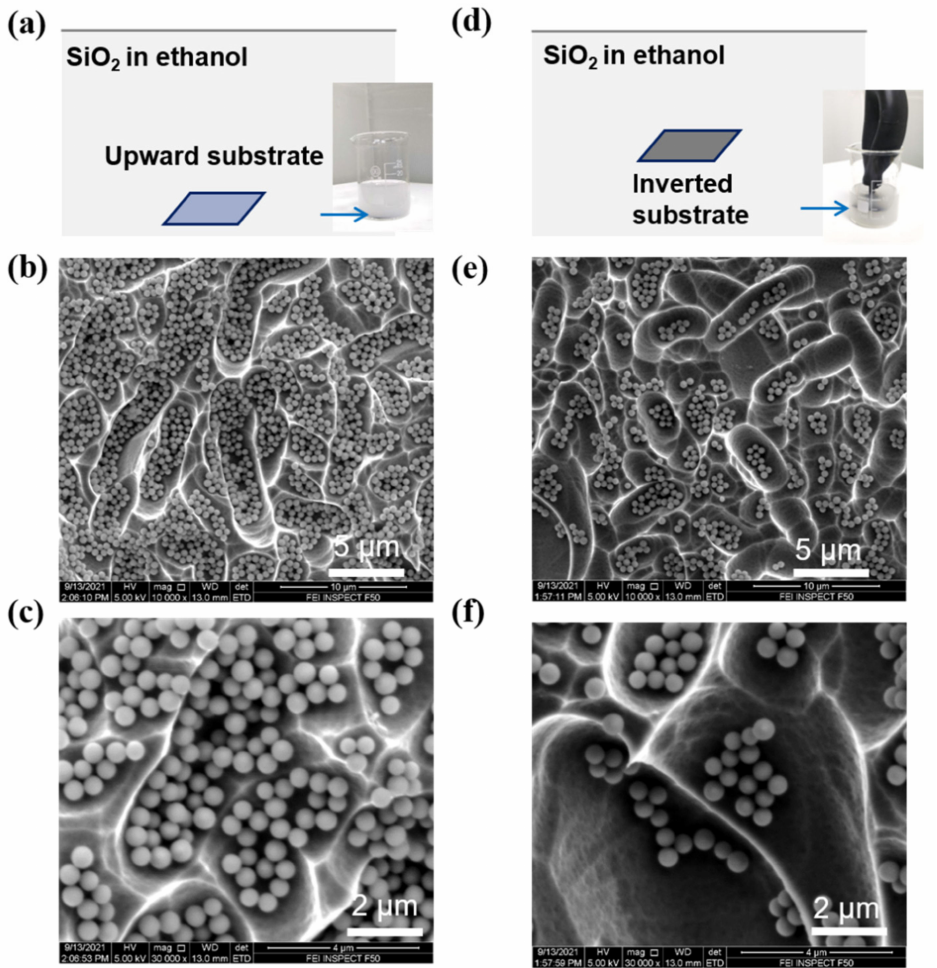
Figure 3. Self-assembly nanocoating under different substrate orientations in the SiO 2 assembly colloid: ( a – c ) Self-assembly with an upward substrate; ( d – f ) Self-assembly with an inverted substrate. The assembly time was fixed to 10 min for all the assembly processes, and the inset figures in ( a ) and ( d ) are the images of assembly in colloidal SiO 2 . The blue arrows indicate the location of the devices. A vacuum suction ball was used to keep the substrate upside-down during the assembly process in the inverted